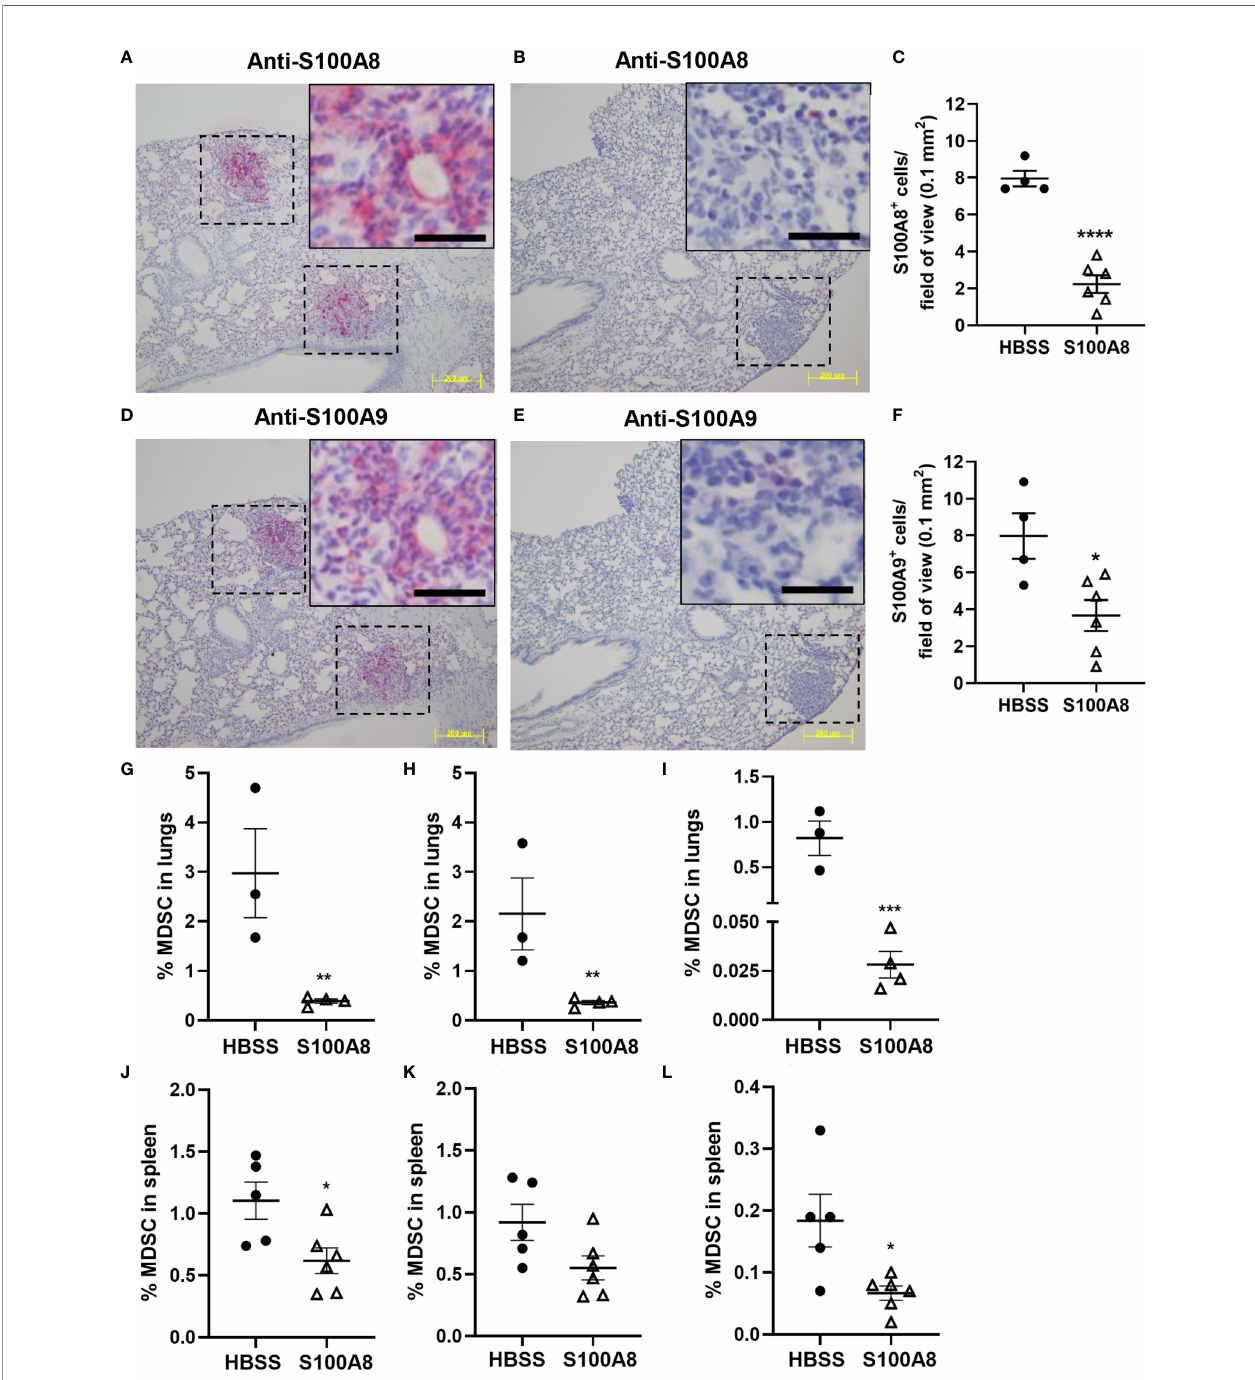
FIGURE 5 | Inhalation of S100A8 suppressed MDSC accumulation in lungs and spleen from tumor-bearing mice. (A, B) Representative images showing S100A8 immunoreactivity in lung tumors (dotted lines) following HBSS (A) or S100A8 (B) treatments on Days 3, 6 and 9 post-LLC cell implantation; scale bars, 200 m m. Insets show magni fi ed regions of tumors; scale bars, 20 m m. Lungs were harvested on Day 10. (C) Graph showing mean numbers ± SEM of S100A8 + myeloid cells per fi eld of view (0.1 mm 2 ), n = 4-6 mice per treatment group, ****p < 0.0001. (D, E) Representative images showing S100A9 immunoreactivity in lung tumors (dotted lines) following HBSS (D) or S100A8 (E) treatments on Days 3, 6 and 9 post-LLC cell implantation and harvested on Day 10; scale bars, 200 m m. Insets show magni fi ed regions of tumors; scale bars, 20 m m. (F) Graph showing mean numbers ± SEM of S100A9 + myeloid cells per fi eld of view (0.1 mm 2 ), n = 4-6 mice per treatment group, *p < 0.05. (G – L) Graphs showing mean percentages ± SEM of total MDSC (G) , PMN-MDSC (H) and M-MDSC (I) in lungs and total MDSC (J) , PMN-MDSC (K) and M-MDSC (L) in spleen from tumor-bearing mice treated with HBSS or S100A8 on Days 3, 6 and 9 post-LLC cell implantation and harvested on Day 10, n = 3-6 mice per treatment group, *p < 0.05, **p < 0.01 and ***p <